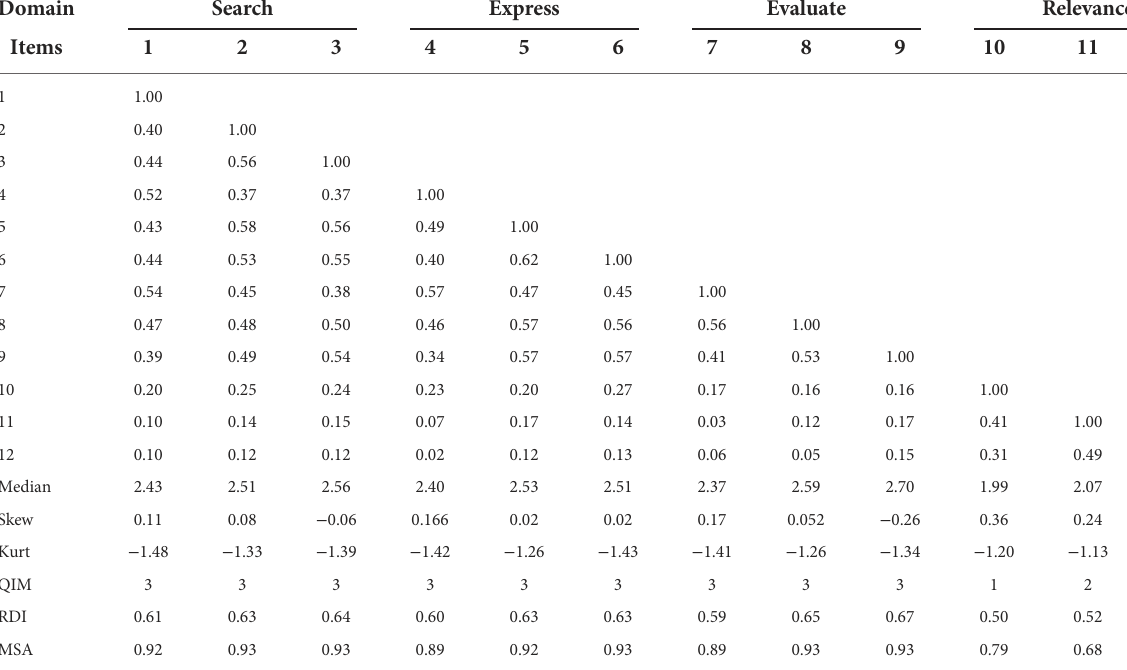
TABLE 1 Polychoric matrix, median, skewness and kurtosis of the items. Domain Search Express Evaluate Relevance